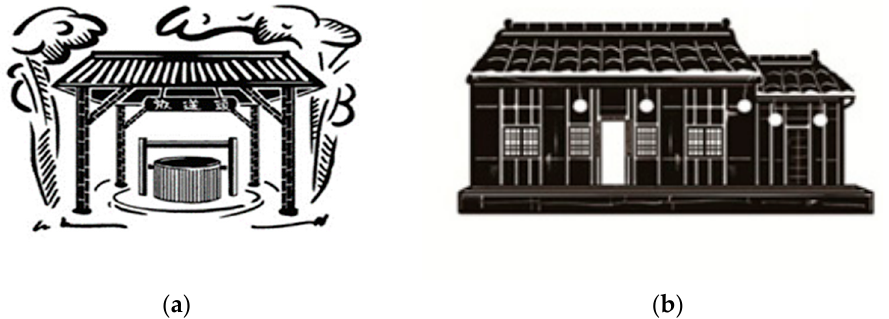
Figure 1. Creations from the Stage 1 IEC workshops. ( a ) Serigraph “Fangsongtou old well” (by E6-C-Week06). In Taiwanese Hokkien, Fangsongtou means “to broadcast using a loudhailer”. The well was named Fangsongtou because it was an important site for information transmission. The elders used to go there to fetch water and do their washing. It was also a playground for children. The community residents recalled the site as a locale for exchanging pleasantries and catching one another up about their current situation and interesting news. ( b ) Serigraph “Great-grandparents’ old house” (by E14-C-Week06). This used to be the residence of a senior who was quite advanced in age. It was built using only tenon joints between bamboo tubes, showcasing high-precision craftsmanship. The internal layout and consideration of daily necessities reflect the life trajectory and historical backdrop at that time.